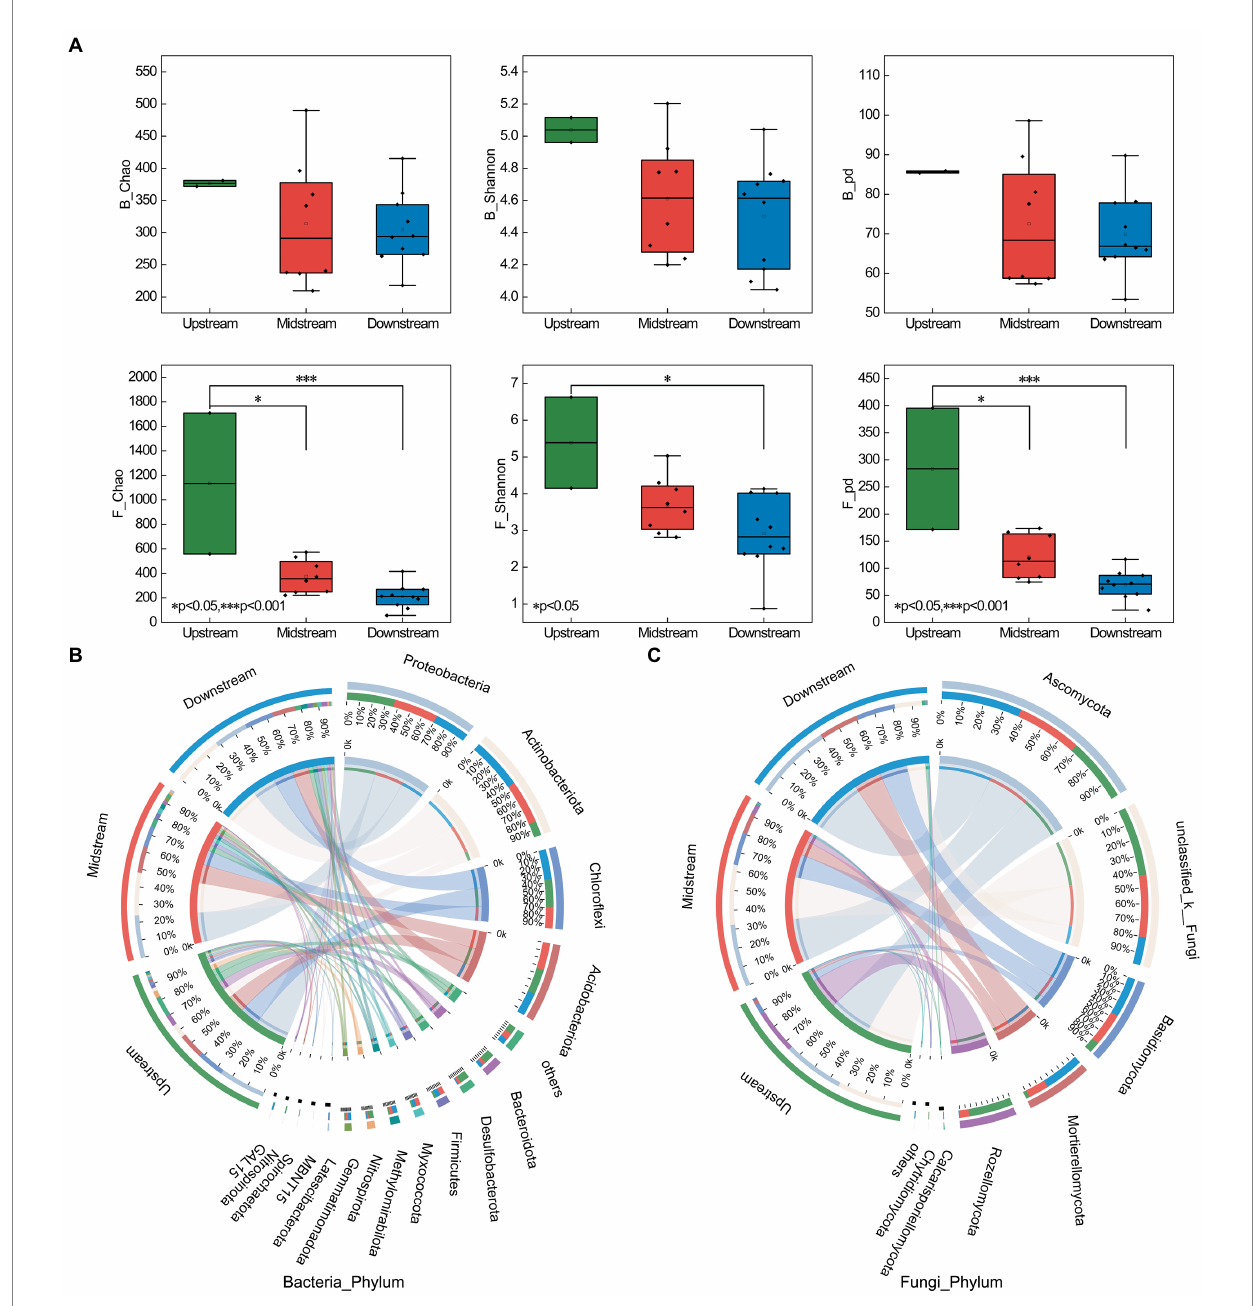
FIGURE 3 The alpha diversity and microbial communities in riparian zones of the TGR. (A) Distribution of alpha diversity (bacteria and fungi) in the riparian zone (upstream, midstream, and downstream). (B) Relative abundance of bacterial communities at the phylum level (upstream, midstream, and downstream); B_Chao, Chao index of bacterial community; F_Chao, Chao index of fungal community. (C) Relative abundance of fungal communities at the phylum level (upstream, midstream, and downstream). * p < 0.05, ** p < 0.01, *** p <